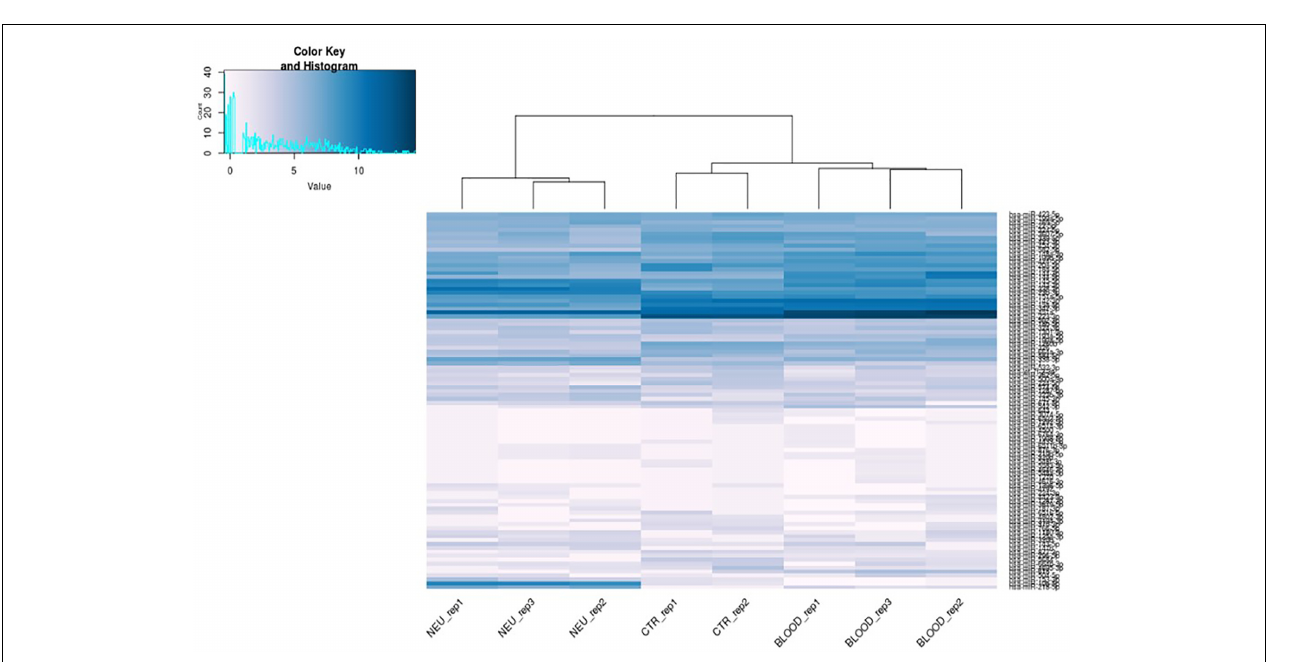
FIGURE 3 | Heat map of differentially expressed microRNAs. Blue represents upregulation and white represents